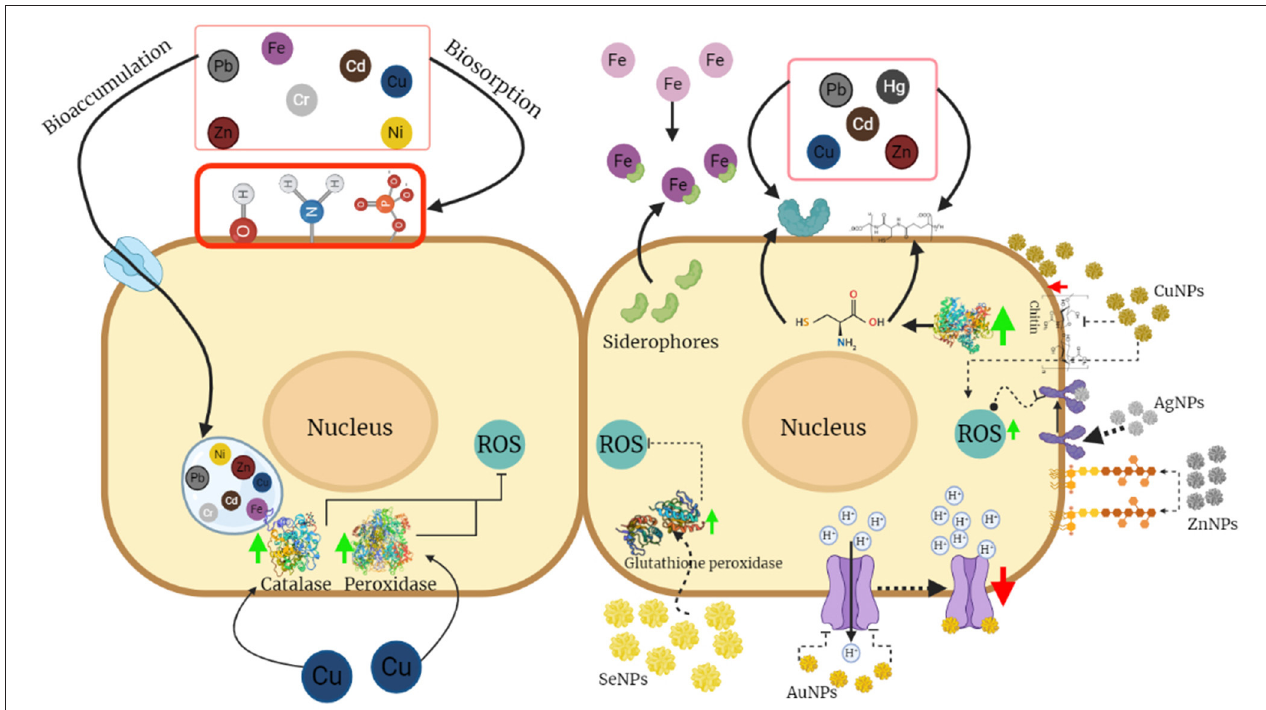
FIGURE 2 | Mechanisms of tolerance to metals and nanoparticles (NPs) in Trichoderma . Most of the mechanisms of tolerance to metals are based on processes of adsorption and absorption in the cell walls due to the presence of functional groups, proteins, or compounds that serve as chelating agents, as well as the accumulation of these in the vacuoles. Mechanisms involving the activity of antioxidant enzymes that reduce the damage caused by reactive oxygen species might also be present. This figure was created by